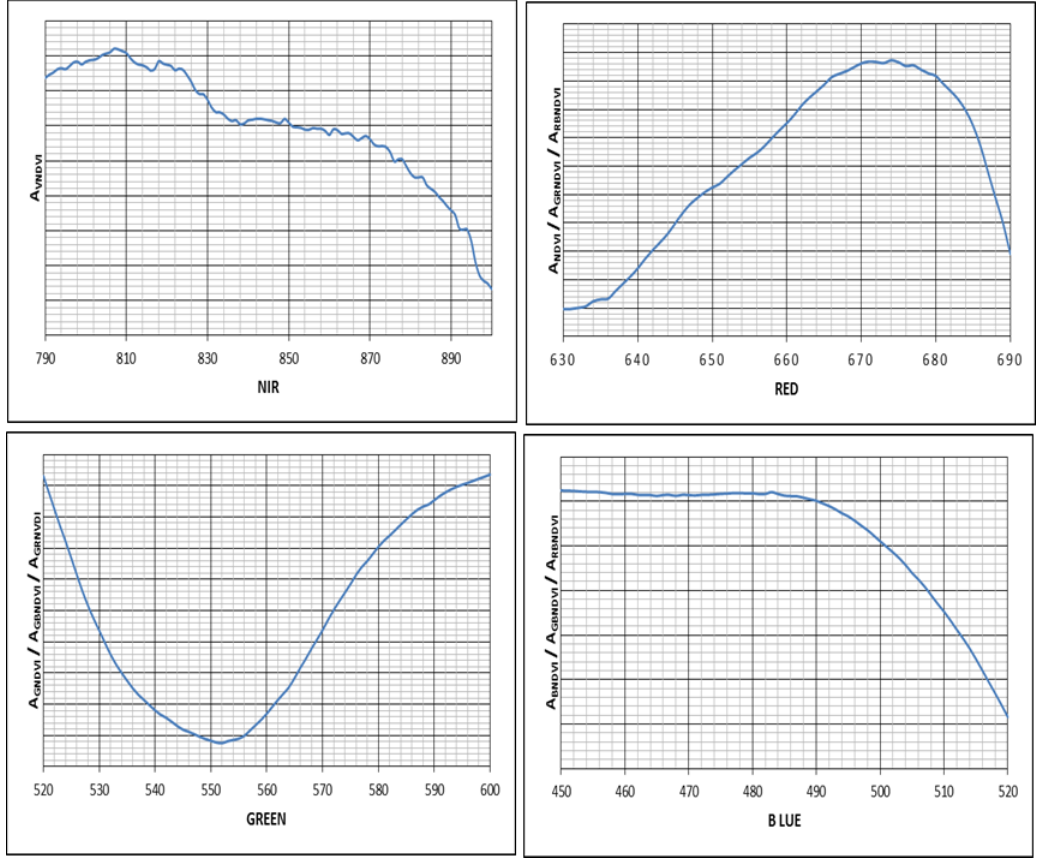
Figure 1. Trends between A VNDVI and reflectivity of the near-infrared, green, blue, and red